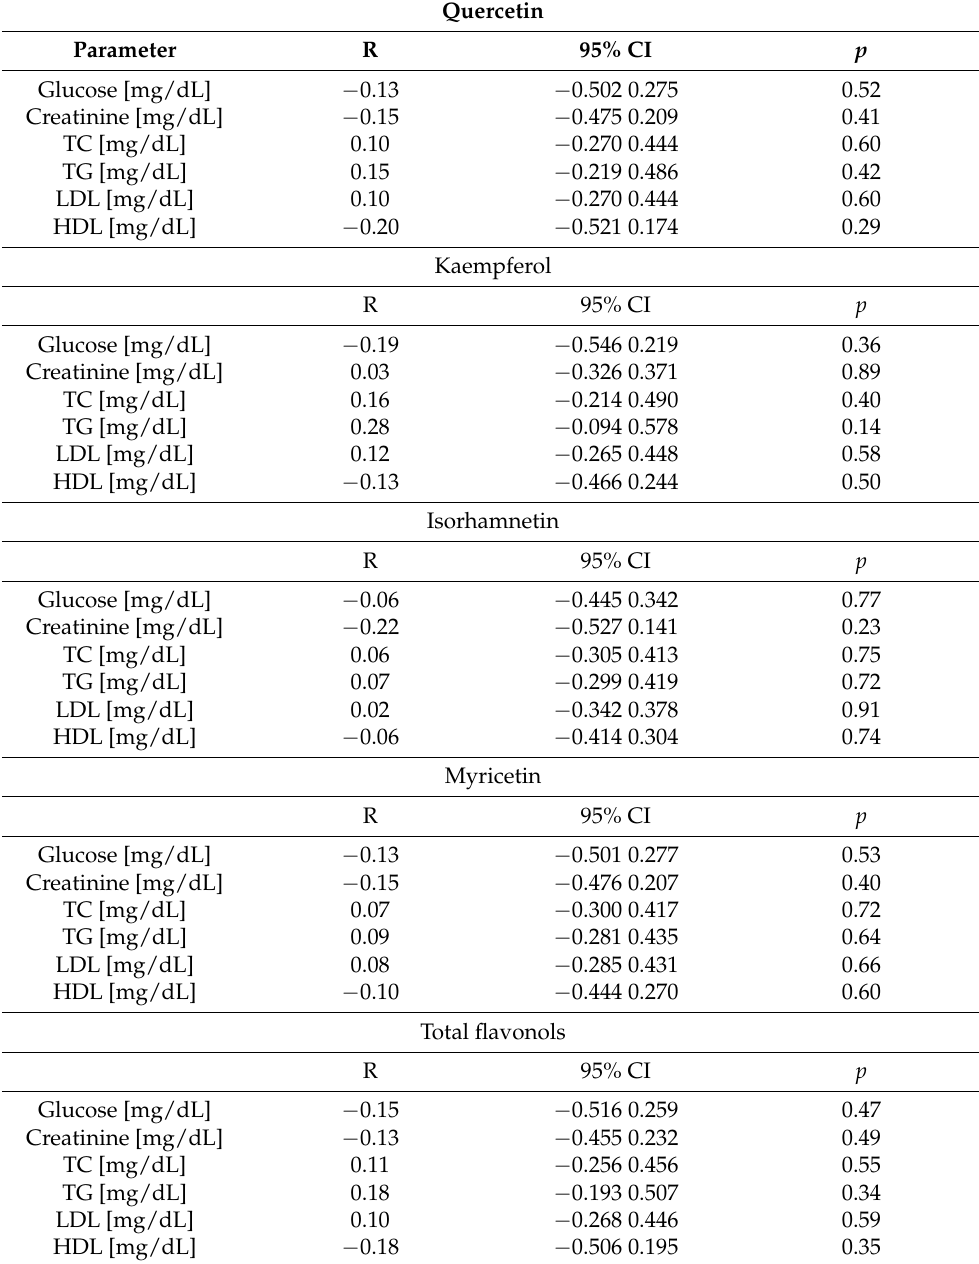
Table 4. The correlation between mean daily flavonol intake and laboratory